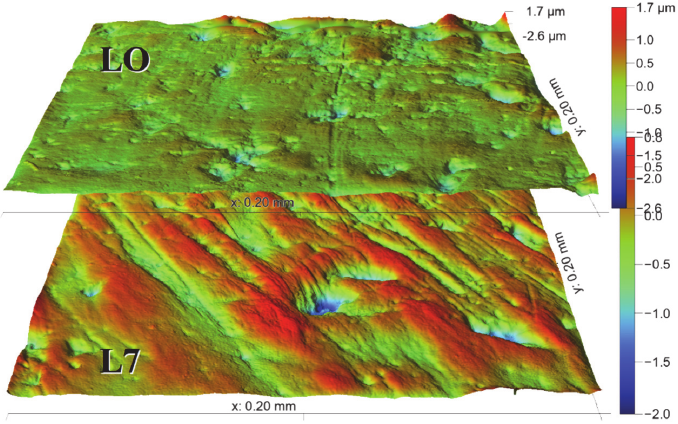
Figure 14 . Visual comparison of two SC surfaces belonging to the LO and the L7 groups. Figure 14. Visual comparison of two SC surfaces belonging to the LO and the L7